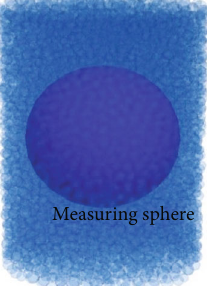
Measuring sphere